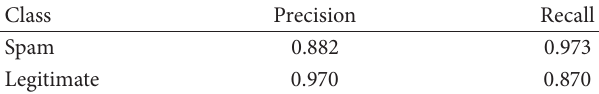
Table 7: Precision and recall of 600 user datasets.